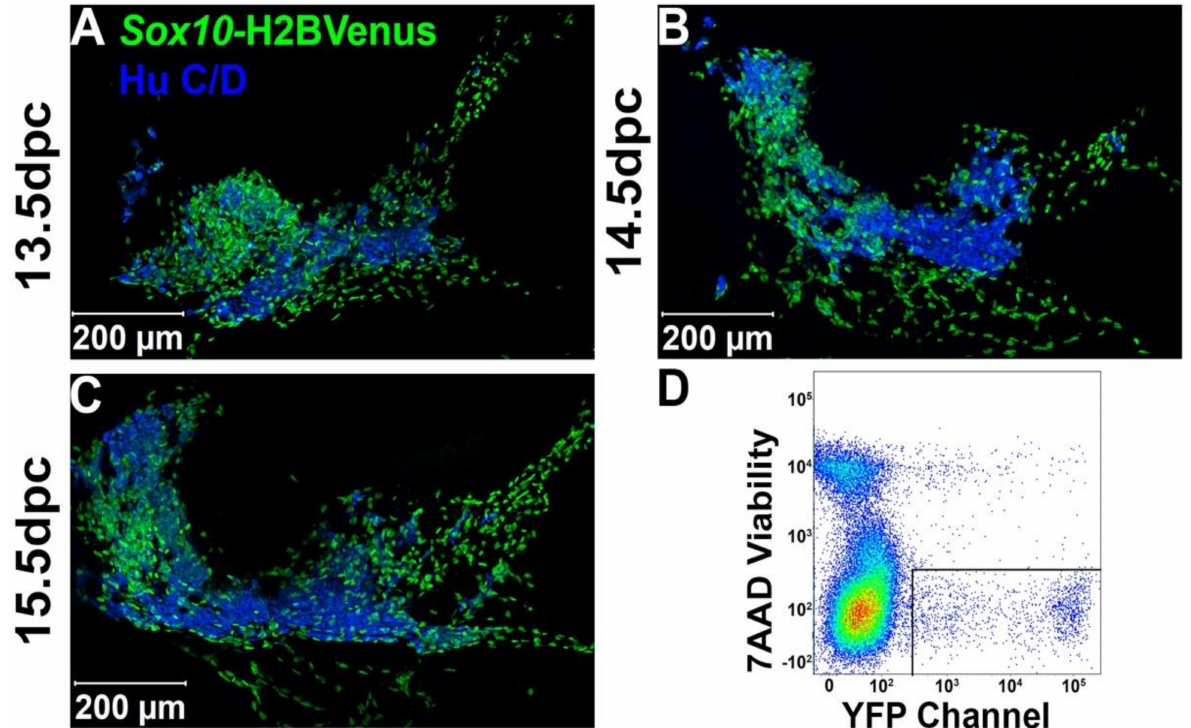
Figure 1. Distribution of Sox10- H2BVenus+ NCPs and neurons in developing fetal pelvic ganglia. Sox10- H2BVenus+ NC-derived cells (green) can be specifically visualized by confocal microscopy and isolated via FACs. Sagittal cryo-sections through a Sox10- H2BVenus transgenic mouse pelvic ganglion at ( A ) 13.5 dpc, ( B ) 14.5 dpc, and ( C ) 15.5 dpc and stained with pan-neuronal marker Hu C/D (blue cells). ( D ) FACS profile of Sox10 -H2BVenus+ cells isolated from the urogenital sinus of 13.5 dpc transgenic mice. Viable cells that excluded 7AAD and that were Venus+ were selected as shown in the boxed gated